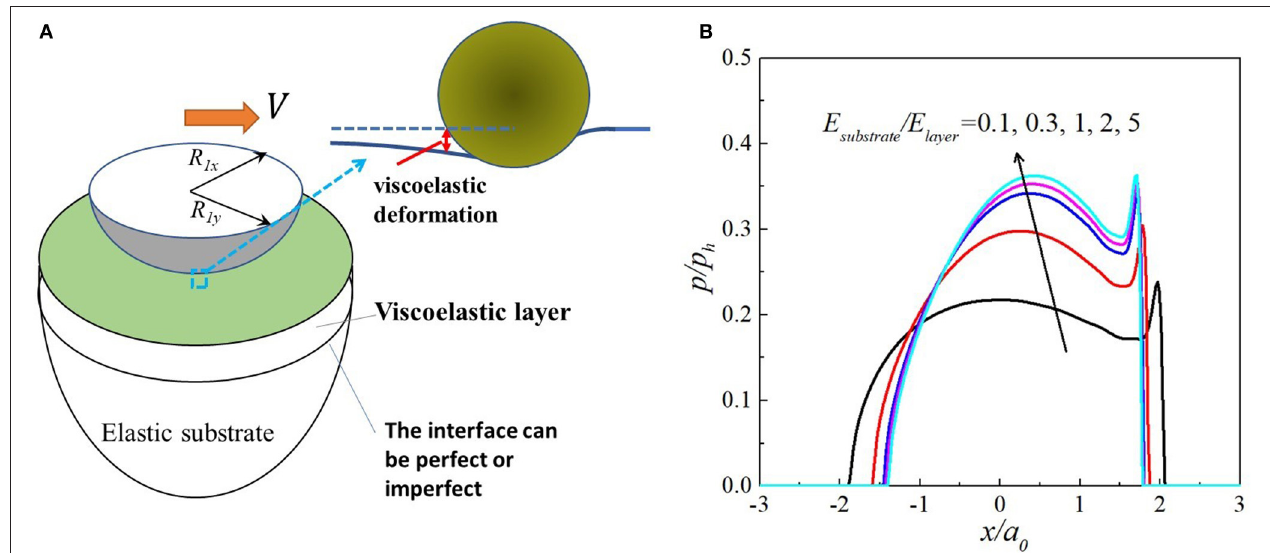
FIGURE 9 | Sliding contact of a viscoelastic layer-elastic substrate system (A) ; and the pressure variations in the case of a sphere sliding on the surface of such a material set at speed V 50 mm/s (B) . This model includes four cases, (1) a viscoelastic layer on an elastic substrate, as shown, (2) a viscoelastic half space, layer = thickness , (3) an elastic half space, layer thickness 0, and (4) an elastic layer on a viscoelastic substrate by exchanging material properties under = ∞ = certain